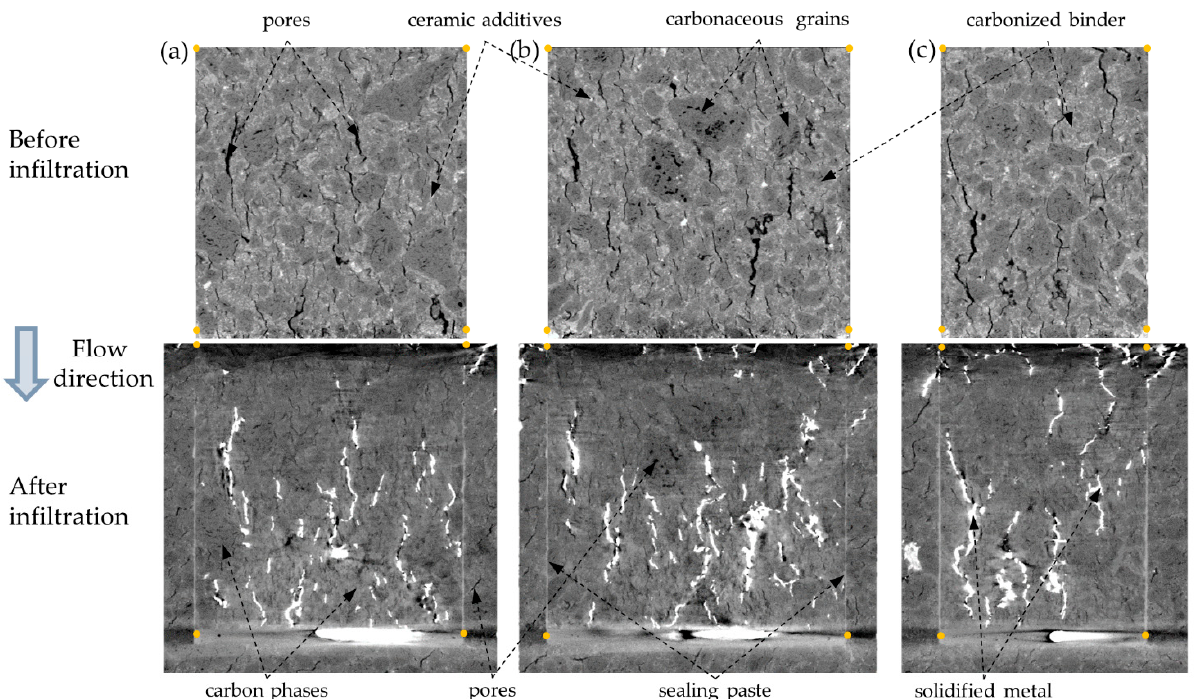
Figure 5. Various 2D cross-sections ( a – c ) in the plane parallel to the molten metal flow of the sample before (top row) and after the HMP test (bottom row).